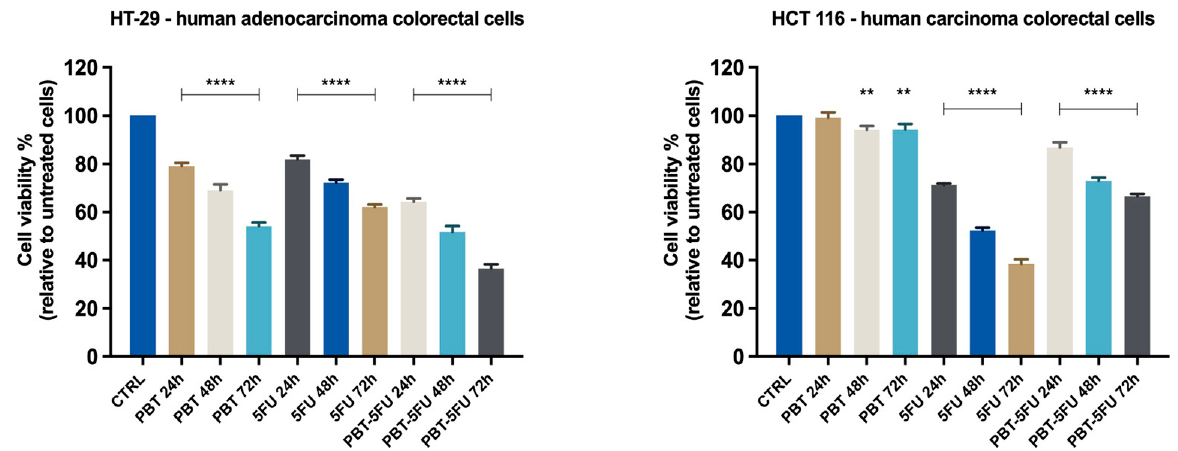
Figure 1. In vitro evaluation of the effect exerted by PBT ( Lactobacillus sporogenes : Clostridium butyricum